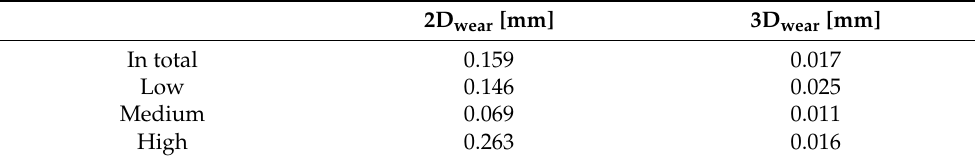
Table 2. Accuracy (bias) of overall and individual wear groups in 2D wear and 3D wear .